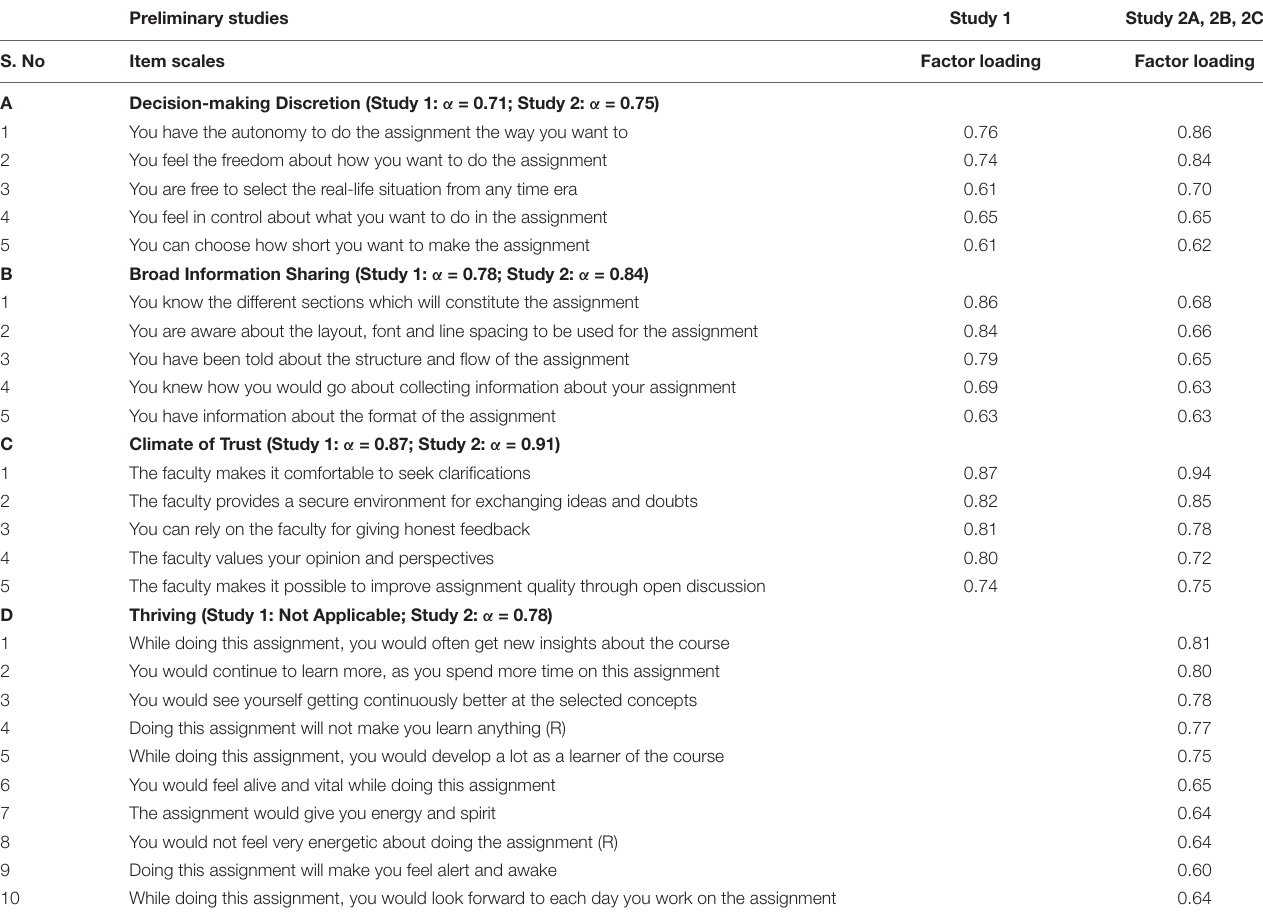
TABLE 1 | Item scales for study 1 and study 2A, 2B and